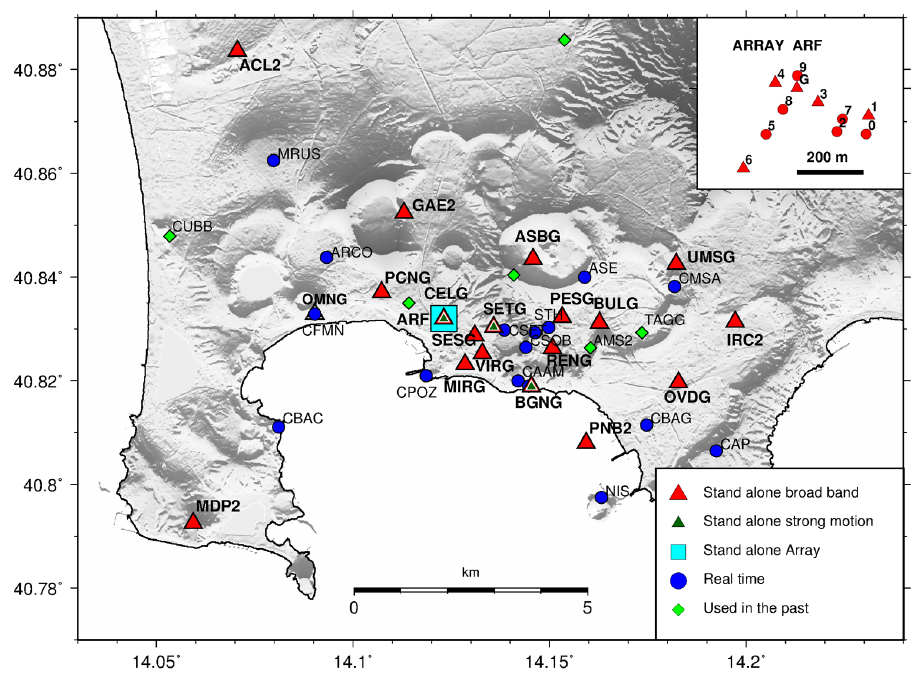
Figure 1. Topography map of Campi Flegrei caldera with the local seismic network currently installed (August 2015). The top right inset shows the current configuration of ARF array.